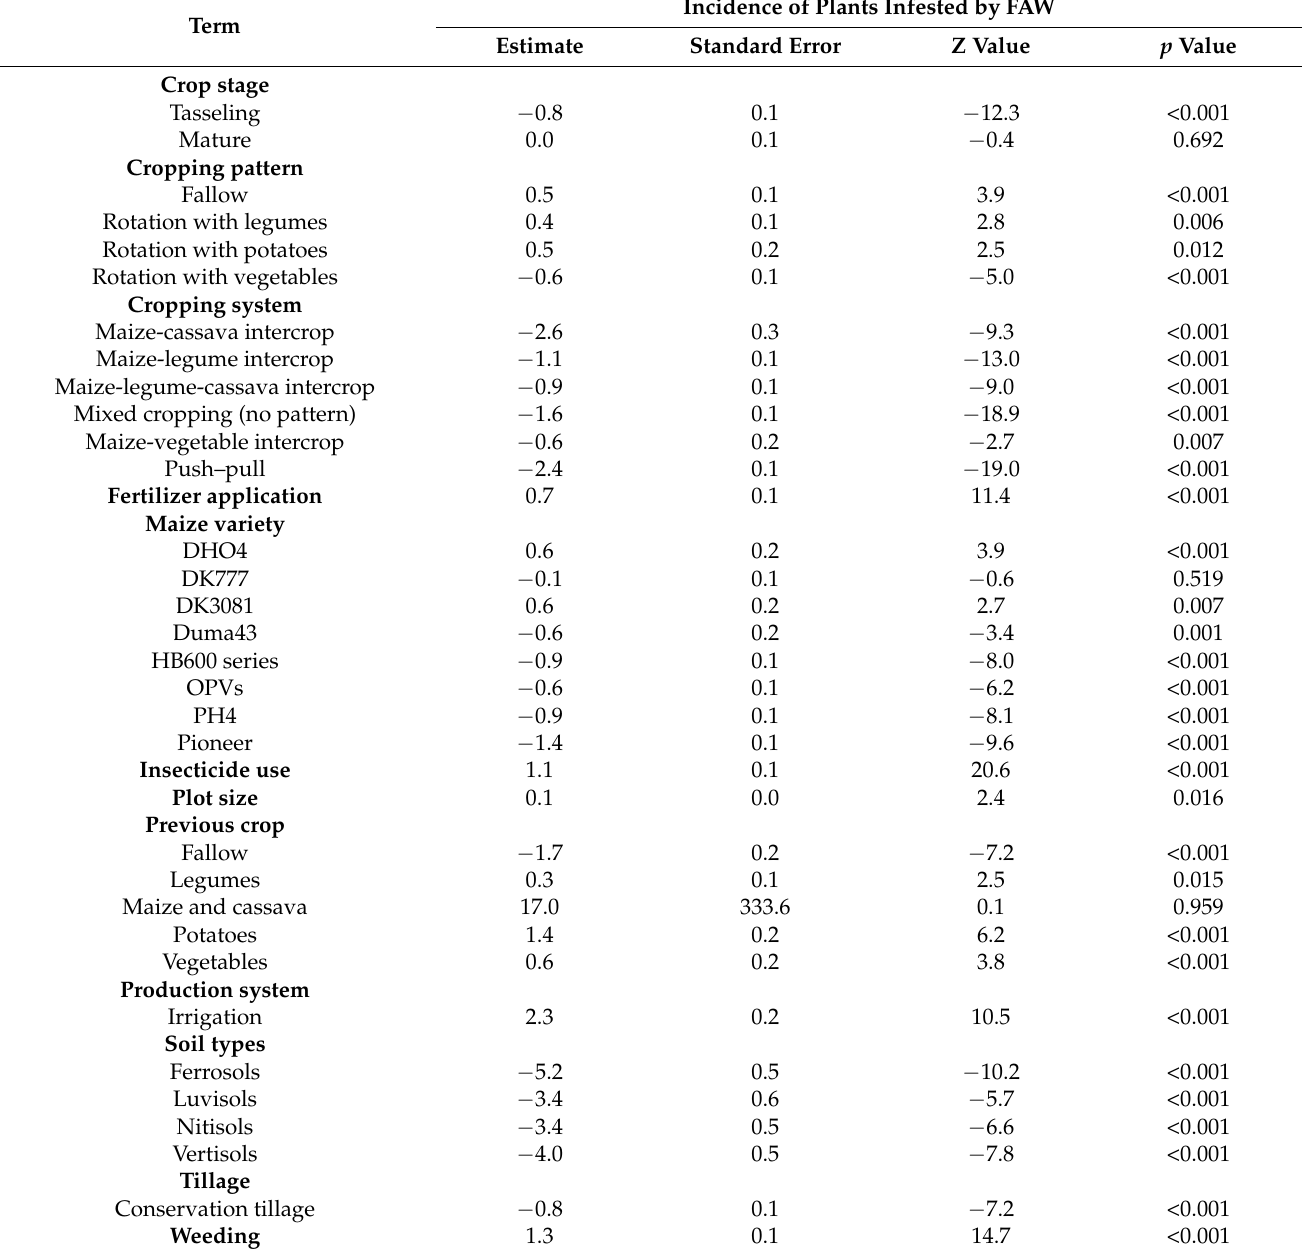
Table 3. Generalized linear models’ results for the aggregated data on maize field characteristics and crop management practices employed by smallholder farmers interviewed during the survey for fall armyworm infestation and damage in three agro-ecological zones of Kenya in 2019/2020. Incidence of Plants Infested by